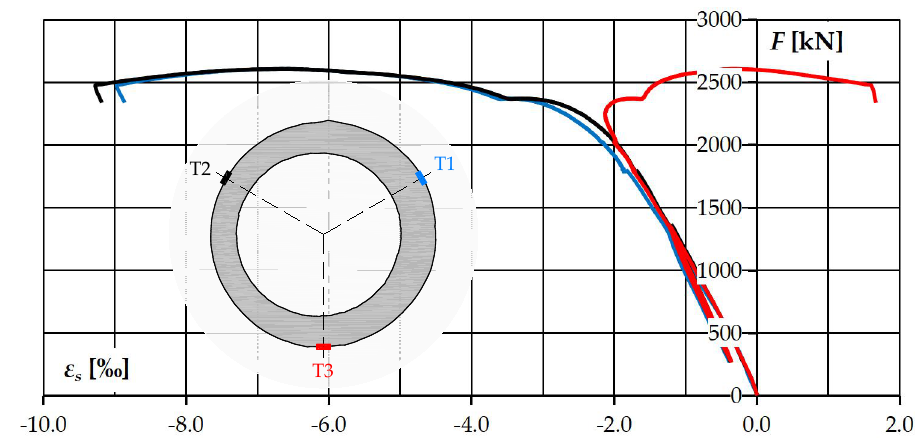
Figure 8. The results of measurements at the mid-height of the column (the colors correspond to the measuring points presented in the cross section).